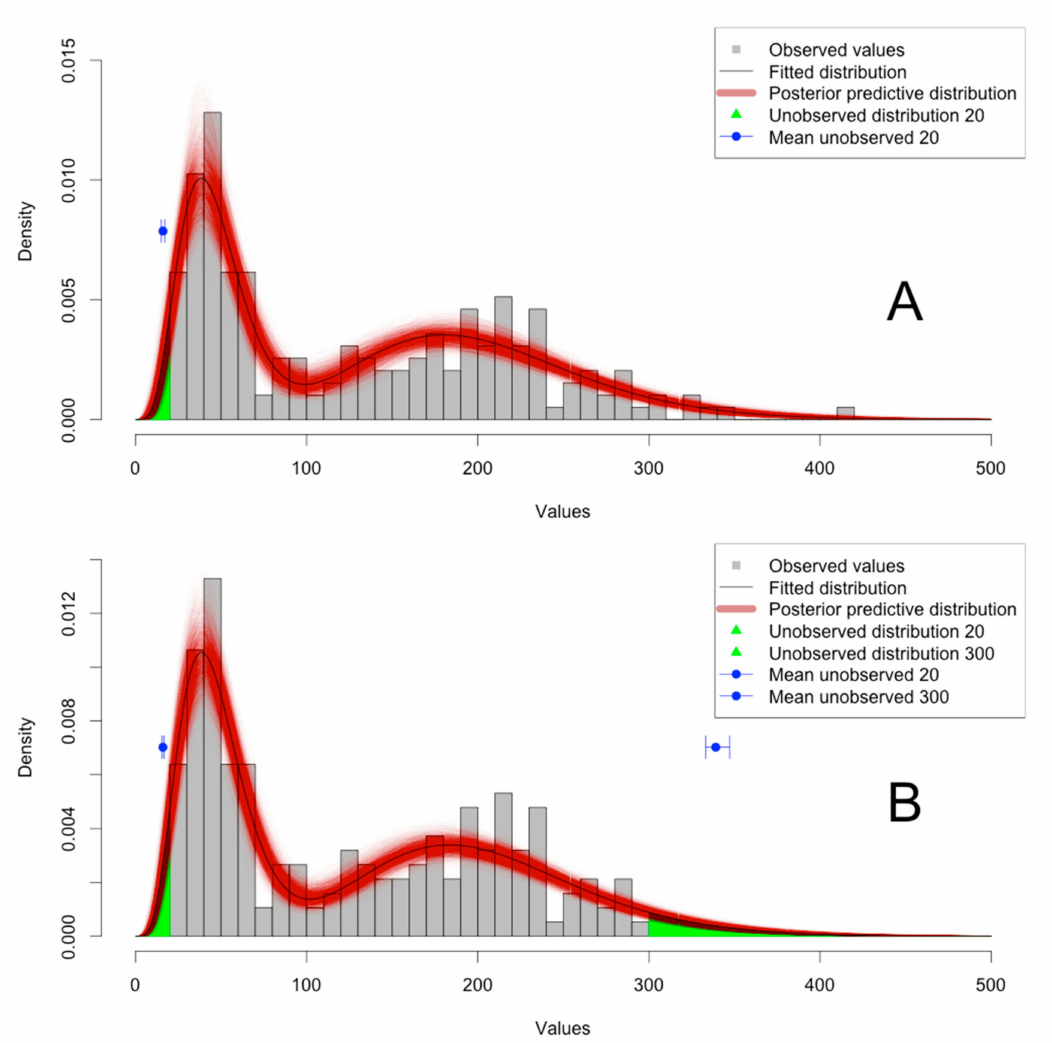
Figure 1. Observed distribution of the fictive set of censored left (LDL = 20; ( A )) and left and right (LDL = 20, UDL = 300; ( B )) data with the corresponding Akaike information criterion AIC-selected model for gamma distribution. Posterior predictive distribution based on 5000 Markov chain Monte Carlo iterations is shown along with the mean and 95% credible interval for values below the lower detection limit (LDL) ( A , B ) and above the upper detection limit (UDL) ( B